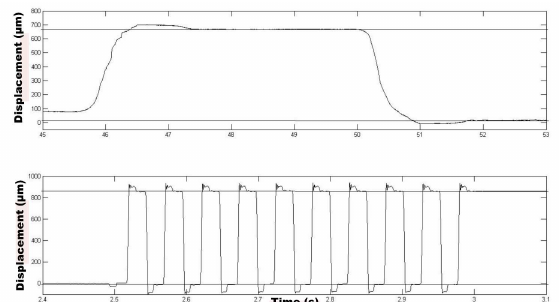
Figure 7: Displacement measurements of the MSMA-based actuator (low and high velocity modes of working).